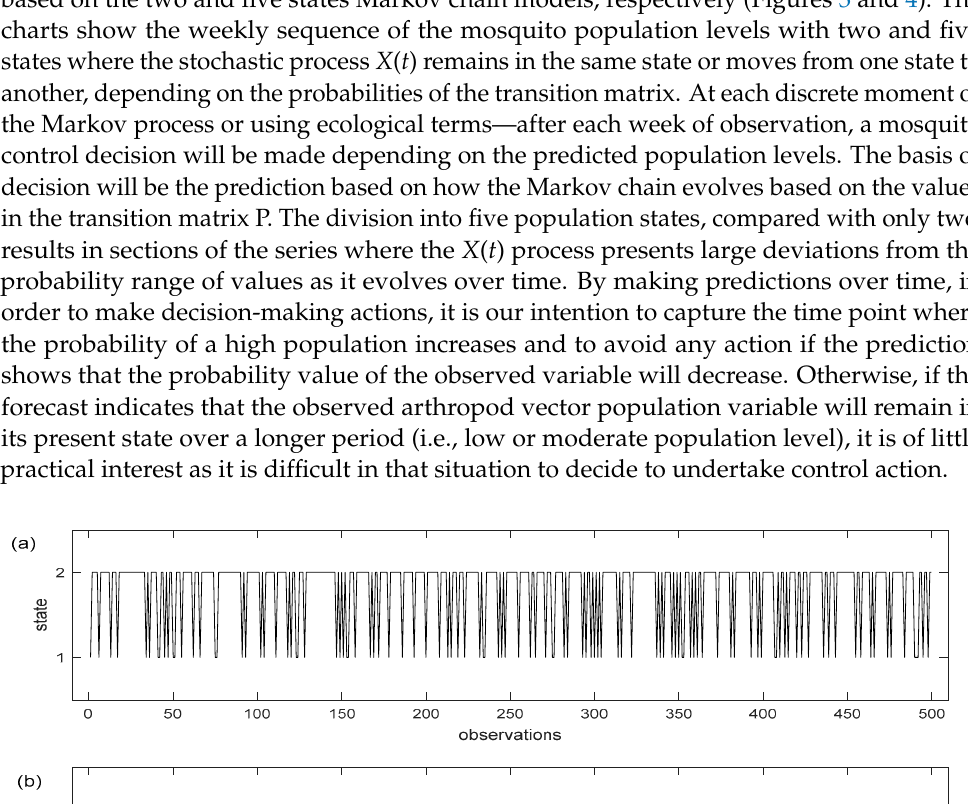
Figure 4. ( a ): Long term sequence of observation of the mosquito population process having five states, ( b ): realization of a Markov chain trained model on these observations, (state 1: very low mosquito population, state 2: low mosquito population, state 3: moderate mosquito population, state 4: high mosquito population, state 5: very high mosquito population). Each time period corre- sponds to an observation for a finite number of successive seasons. The initial state at time 0 corre- sponds to the first observation made. 3.4. Conditional Markov Chain Model Realizations of Mosquito Population Levels Taking into account the temperature-dependent Markov chain, the situation is dif- ferent from the previous example because an additional variable is known from the model